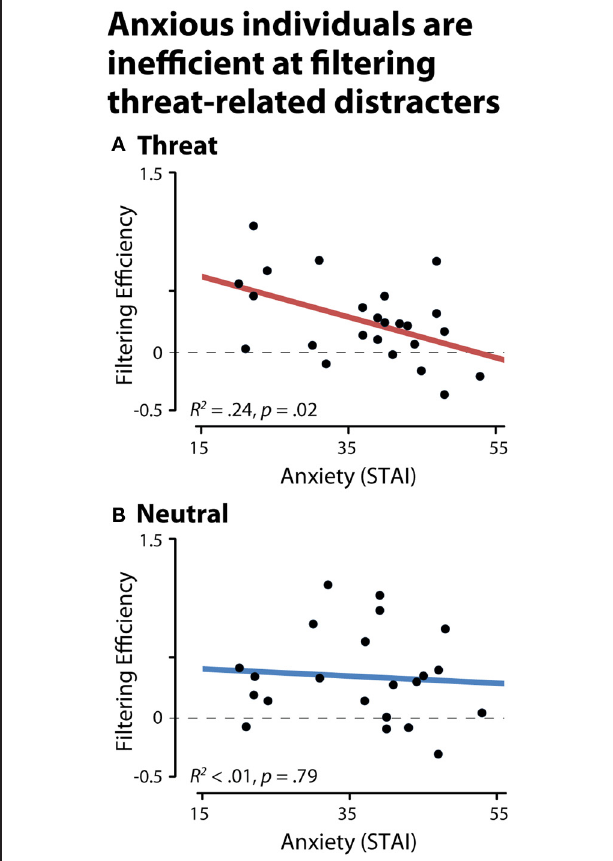
FIGURE 4 | Dispositionally anxious individuals are inefficient at filtering threat distracters, as indexed by contralateral delay activity (CDA). (A) Threat-related distracters. (B) Neutral distracters. A filtering efficiency of zero (broken gray line) indicates a complete failure of filtering (i.e., comparable levels of storage in the distracter and two-target conditions, NT1FT1—NT1FD1 and NT2-NT1ND1).